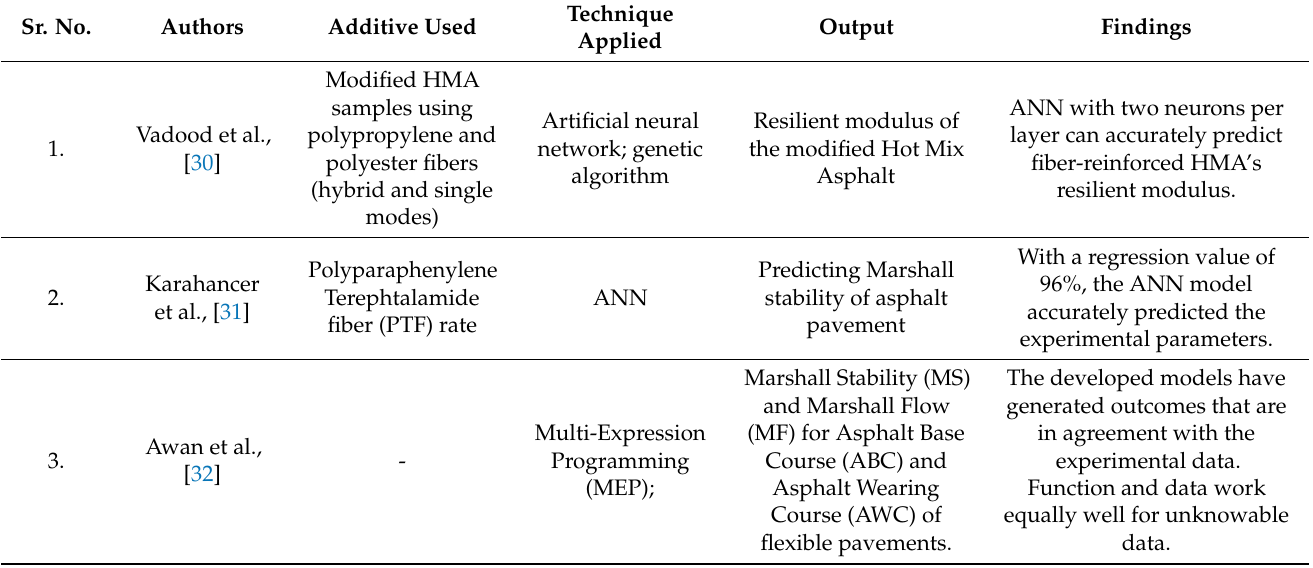
Table 1. Comparison of the approaches used by previous